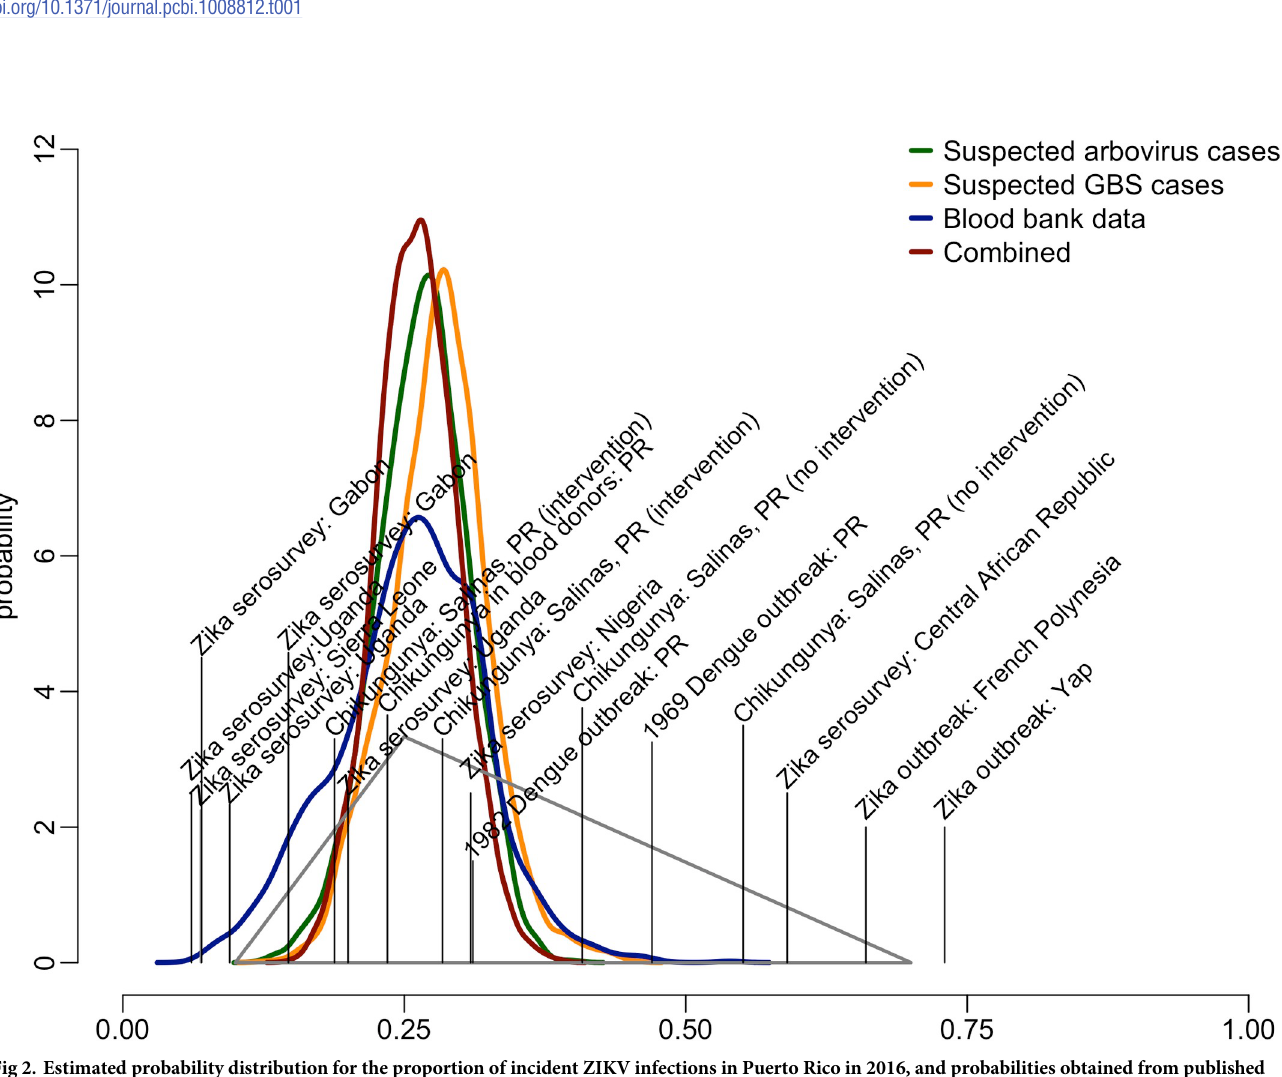
PLOS Computational Biology | https://doi.org/10.1371/journal.pcbi.1008812 March 30,